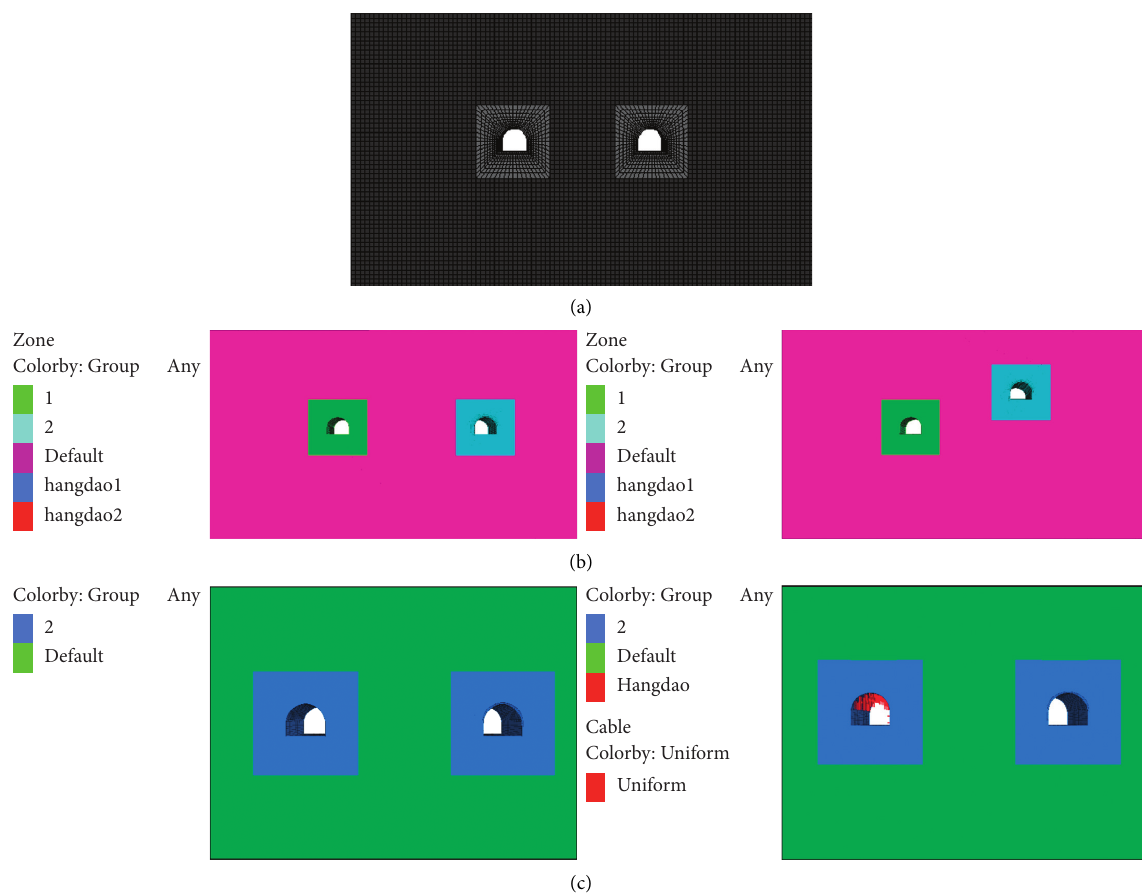
Figure 3: Numerical analysis model: (a) model with 30 m spacing between roadways at the same level; (b) model of 10-horizontal movement and 10-vertical movement; and (c) model with the bolt anchorage of ahead roadway or not.